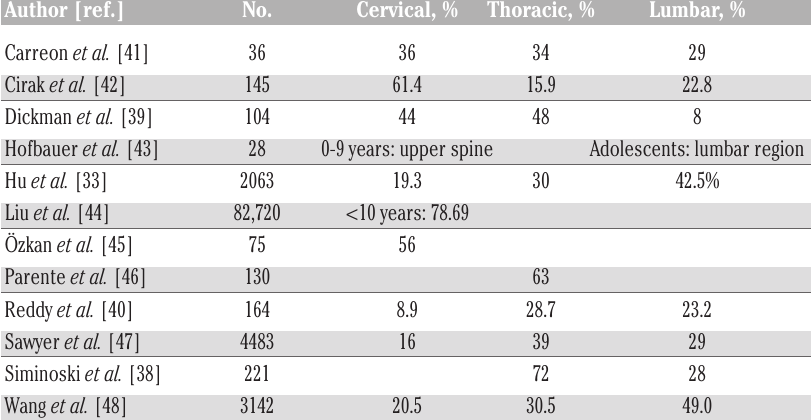
Table 1. Literature localization of injury.